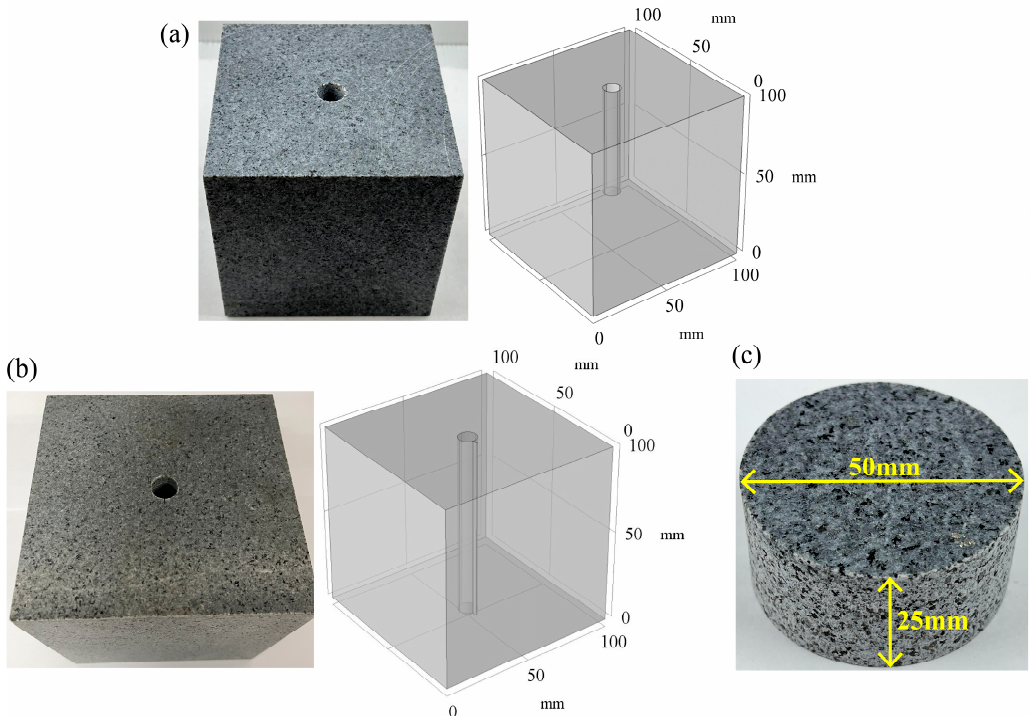
Figure 5. Specimen preparation: ( a ) HFS specimen for hydraulic fracturing tests; ( b ) SFS specimen for secondary fracturing tests; ( c ) BSS specimens for Brazilian splitting tests.